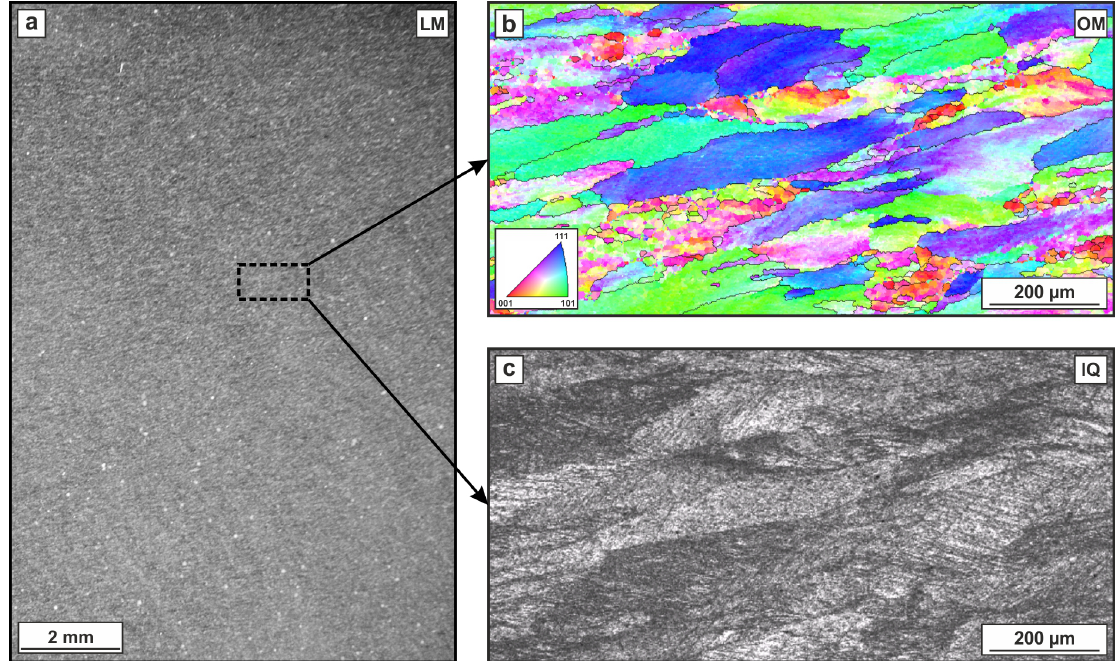
Figure 12. Microstructure after homogeneous shear deformation by one pass of ECAP of a fully recrystallized conventional 6000 series aluminum alloy. Optical micrograph ( a ) showing a microstructural overview and color-coded orientation map (OM) ( b ) and image quality map (IQ) ( c ) from electron back-scatter diffraction (EBSD)